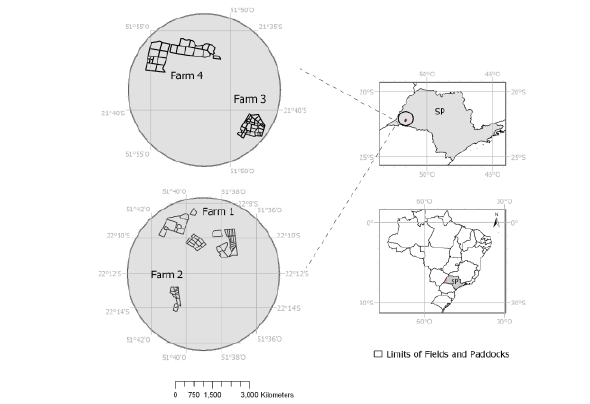
Figure 1. Location of study area with the farms visited